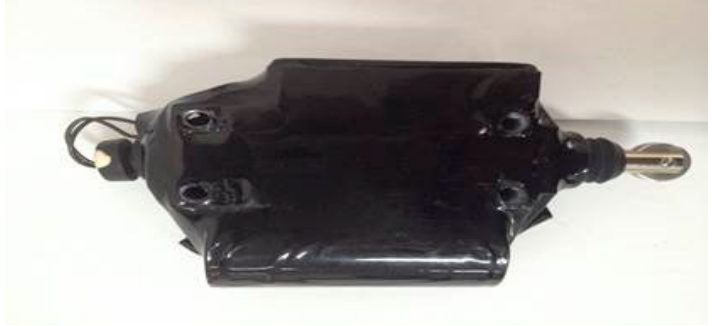
Figure 3. Detecting and communicating sensor of intelligent track skates.